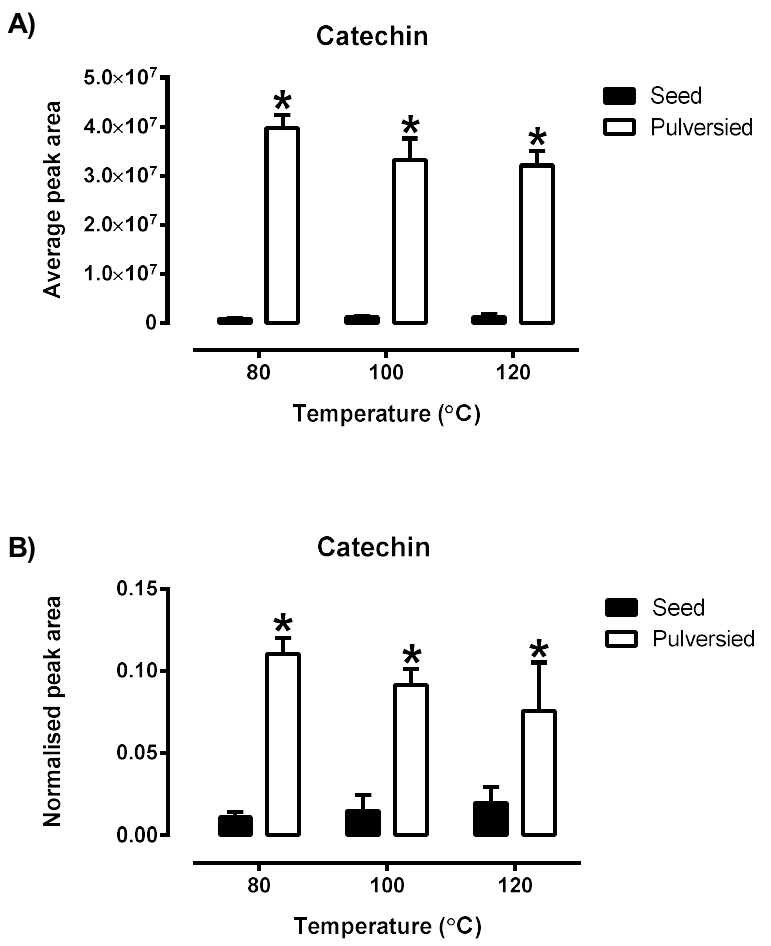
Figure 2. The comparison in the average peak area ( A ) of the phytochemical catechin with the normalised data of the peak area ( B ) derived from Tables S1 and S2 of the pulverised and non-pulverised Bolivian seeds ( n = 3). Each value is represented by mean ± SD with significance accepted at p ≤ 0.05. * Significantly different amount of catechin was found in the pulverised as compared to non-pulverised Bolivia white quinoa (Students’ unpaired t -test).